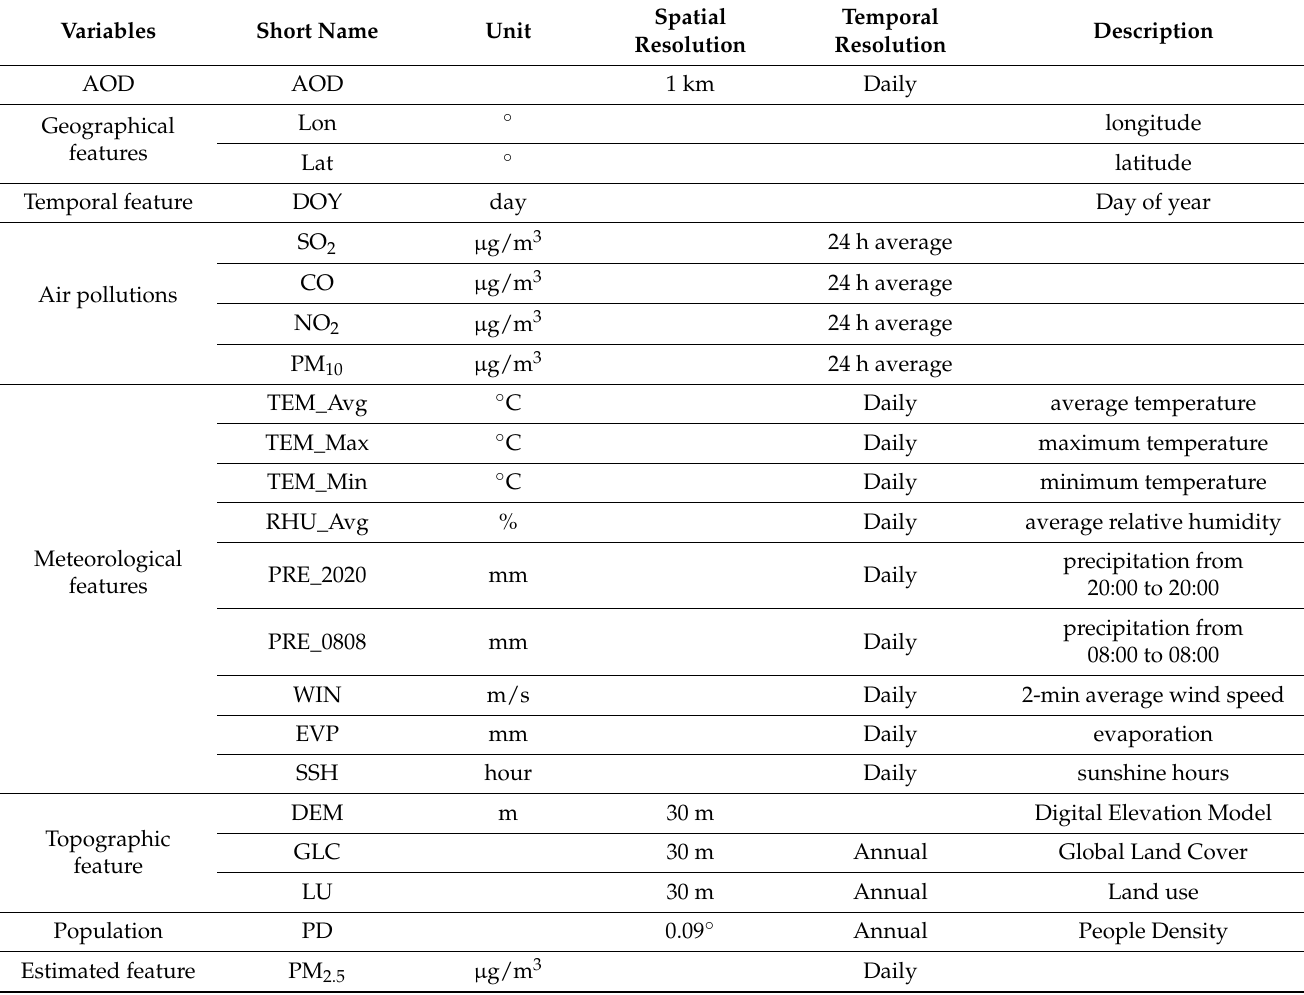
Table 1. Variables used in the model development and